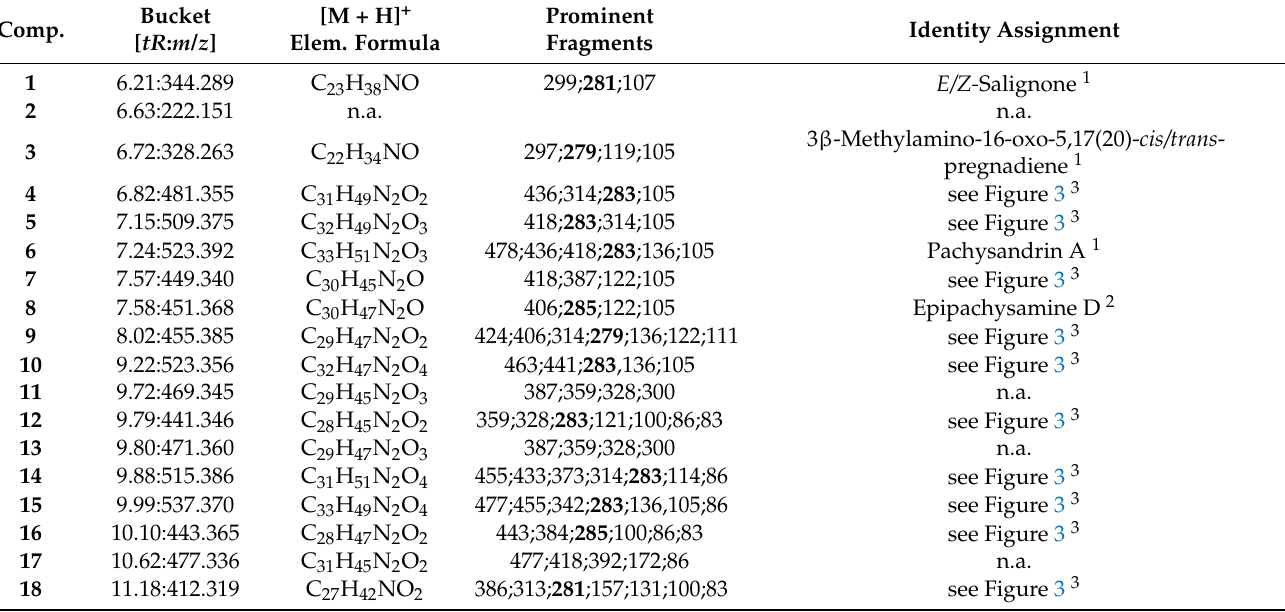
1 Dereplicated as known constituents of P. terminalis on grounds of known fragmentation characteristics as described in [9]. 2 Dereplicated by direct match of MS data with literature. 3 Structure proposed on grounds of known fragmentation characteristics as described in [9]; compare Figure 4. n.a.: not